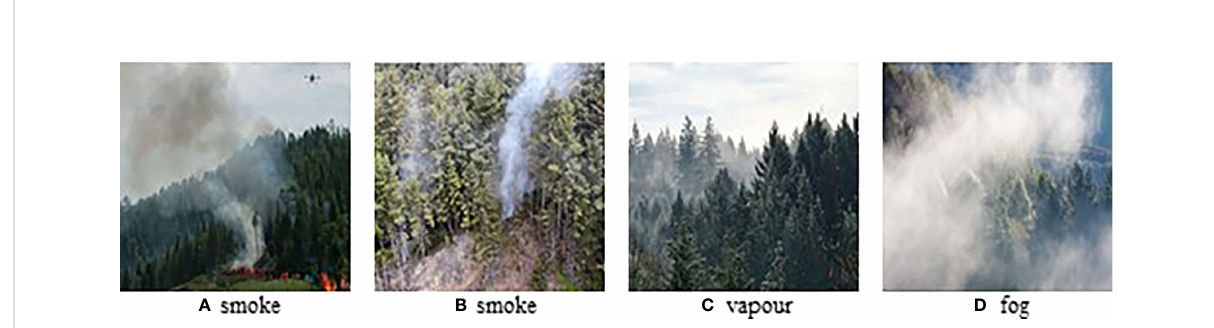
FIGURE 1 Some challenging images. (A, B) are smoke images; (C, D) are vapour and fog